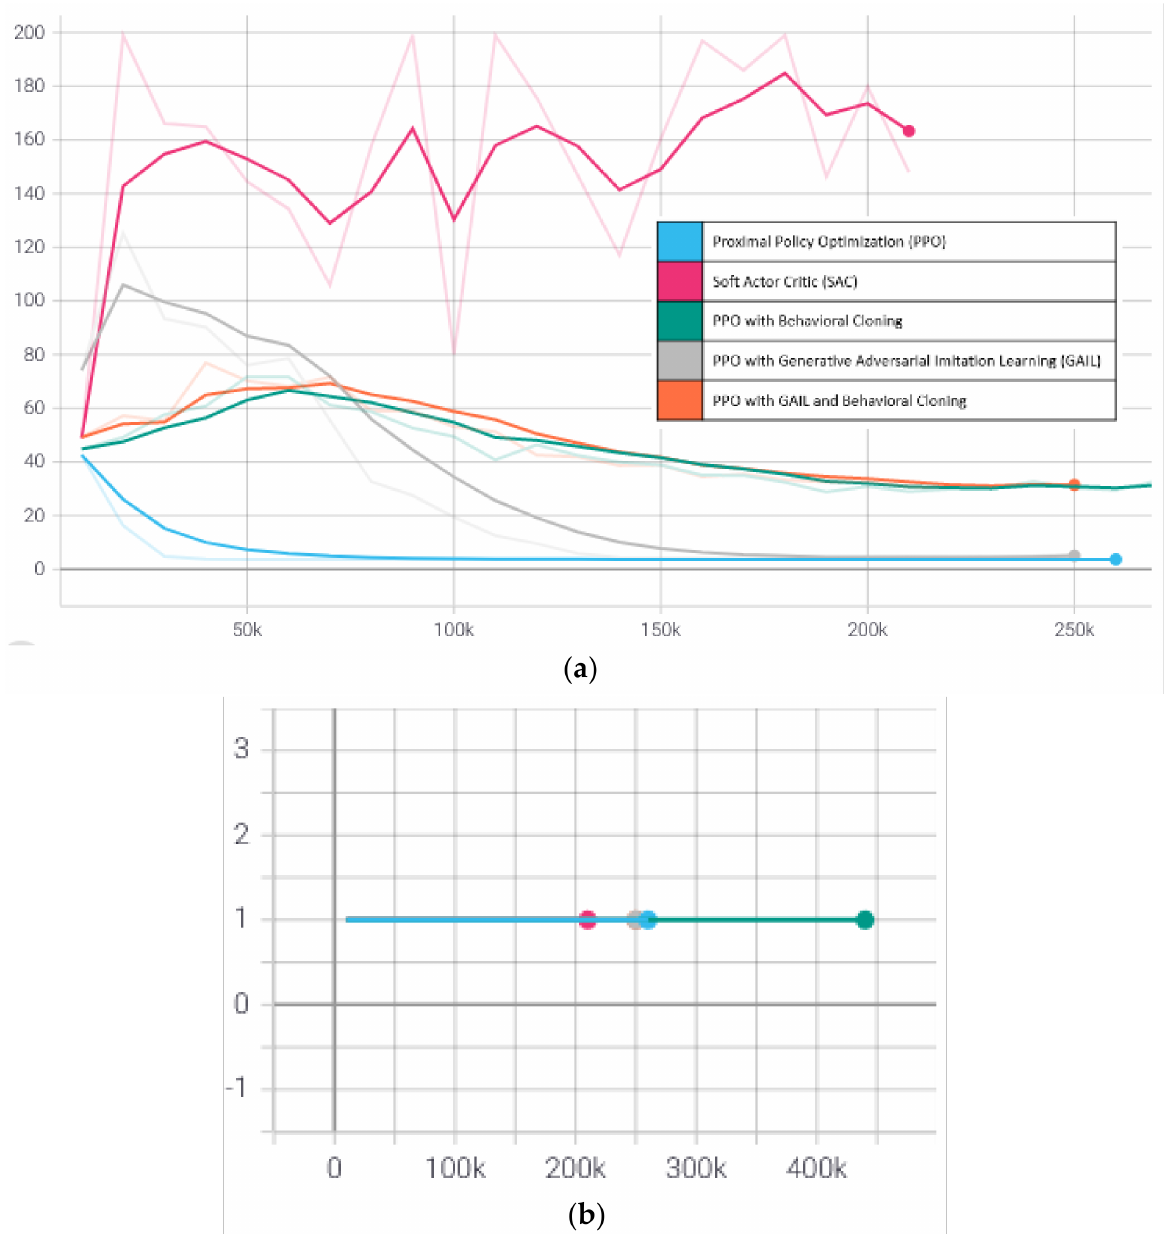
Figure 18. ( a ) Simulation runs vs. episode length, and ( b ) is training (Boolean). The different models exhibit different behaviors for a given simulation set up. The way the user sets up the training environment impacts the performance of the models differently. In Figure 19a,b, the policy loss parameter indicates how much the policy is changing for each agent. Various models have different profiles, and for most models, the magnitude of policy loss decreases indicating successful training. In Figure 20, the entropy measure indicates the degree of randomness of decisions made by the model. The slow decrease of this parameter is an indicator of a successful training session. Entropy profiles are different for different